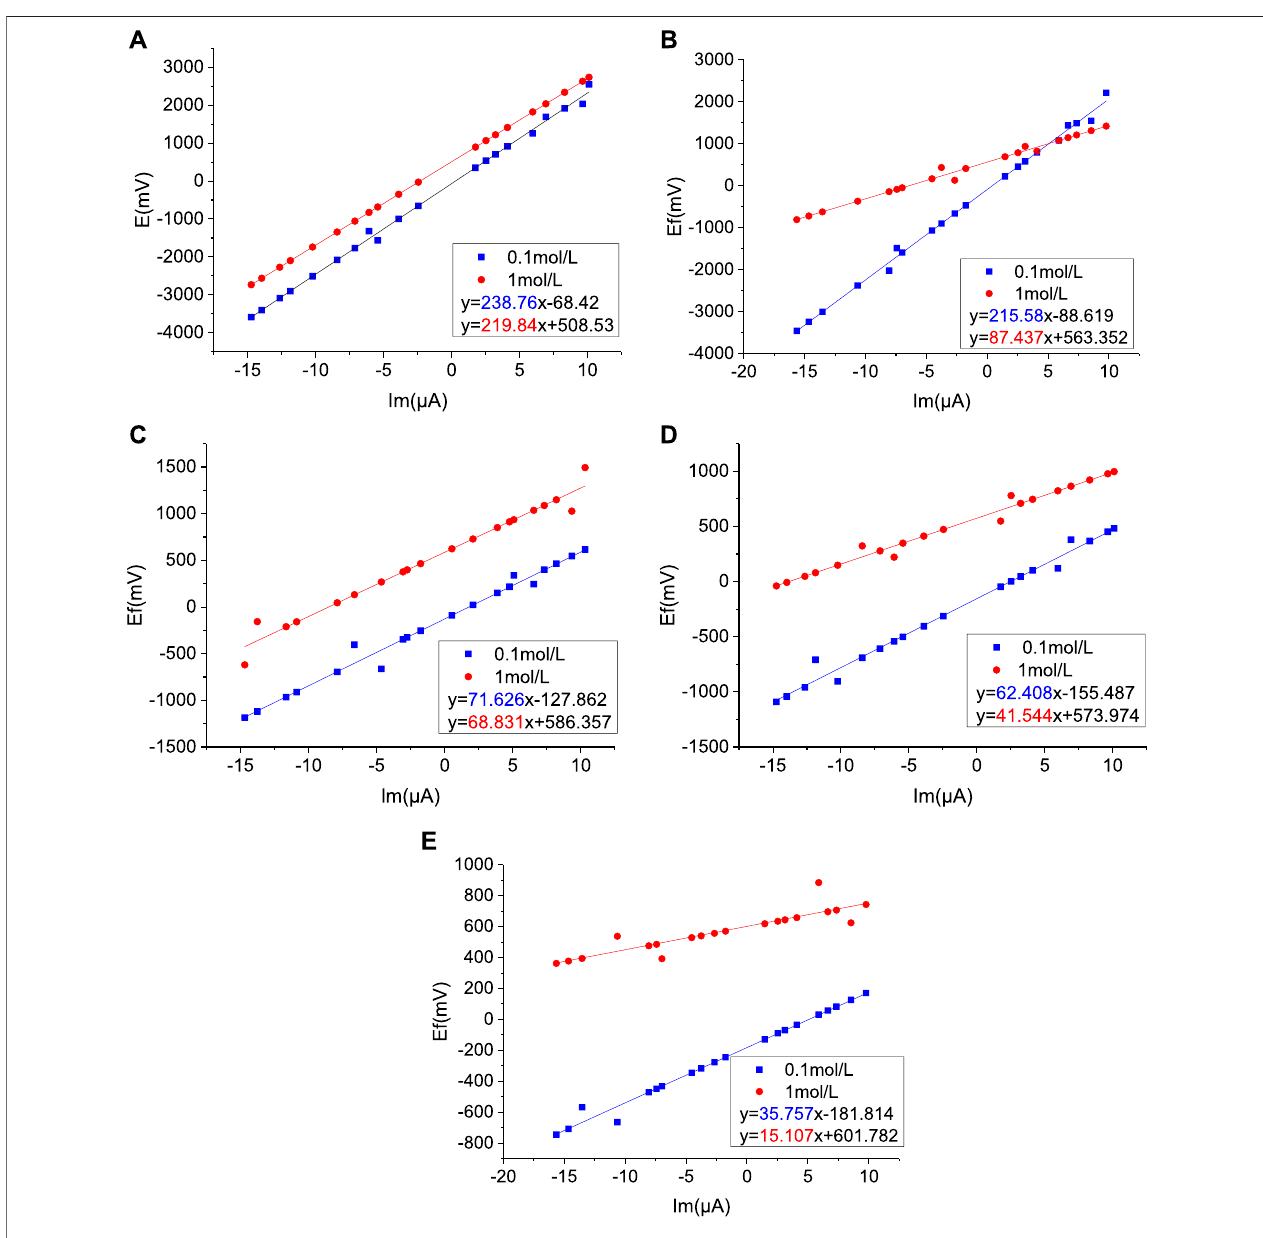
FIGURE 7 | Fitted polarization resistance of S2 and S5 at different times (A) 1d, (B) 3d, (C) 7d, (D) 15d, and (E) 30d.